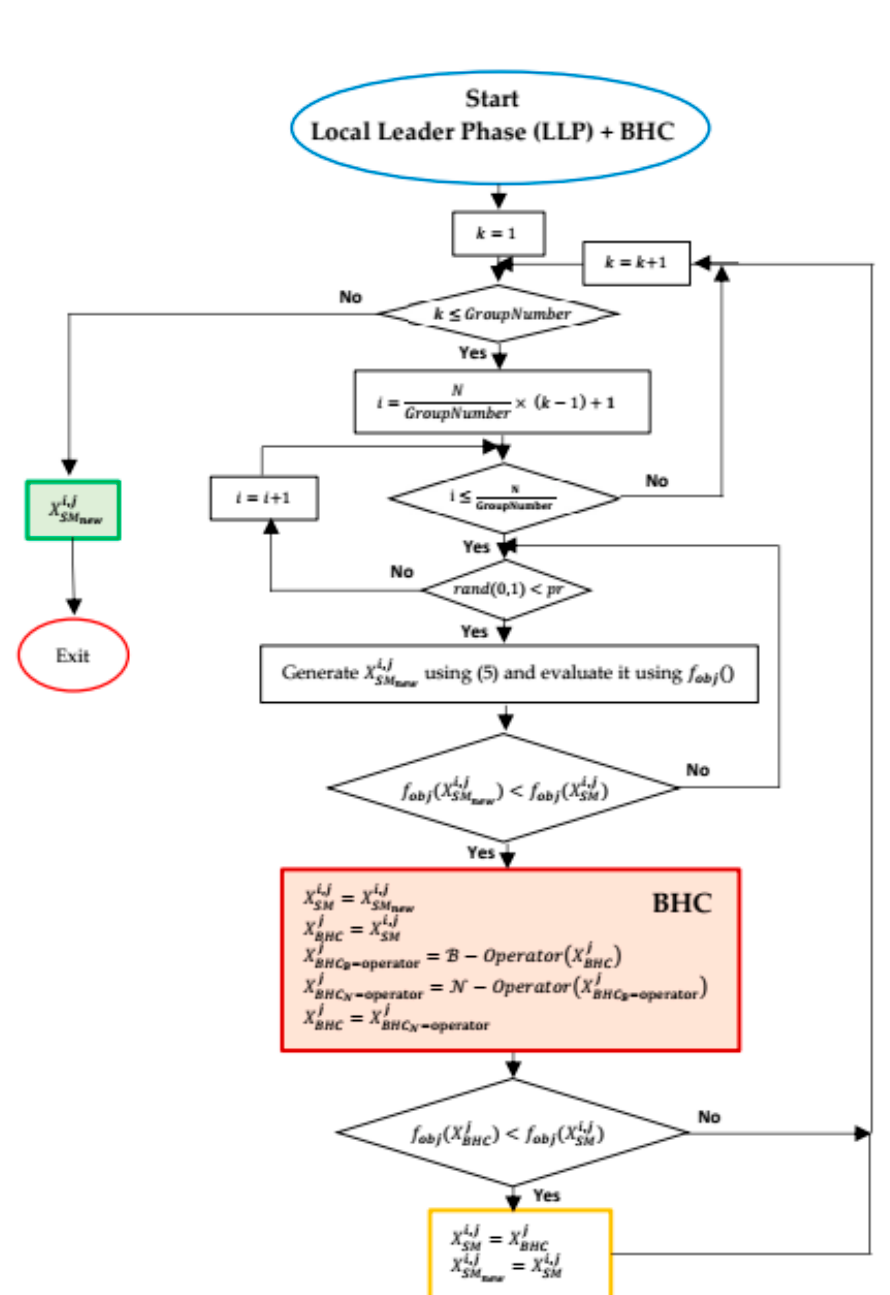
Figure 3. Flowchart of the Local Leader Phase (LLP) based on BHC.